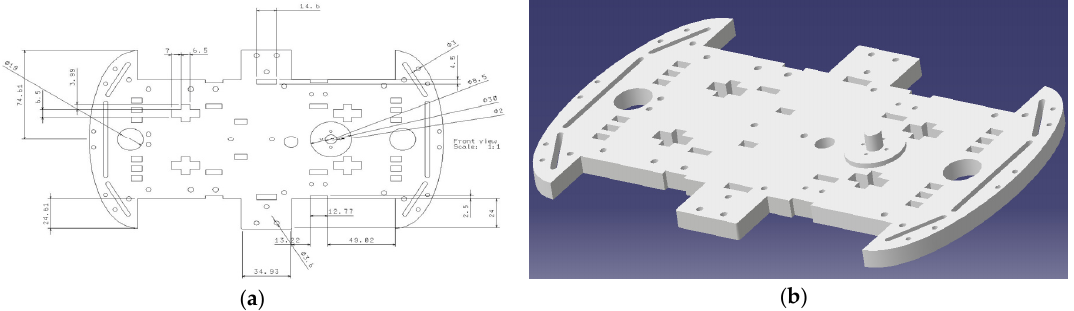
Figure 5. Virtual model of the platform for mini robotic vehicle: ( a ) 2D drawing of the robot platform; ( b ) 3D model of ATIRV main platform based on a commercial kit of 4-wheeled remote controlled car.